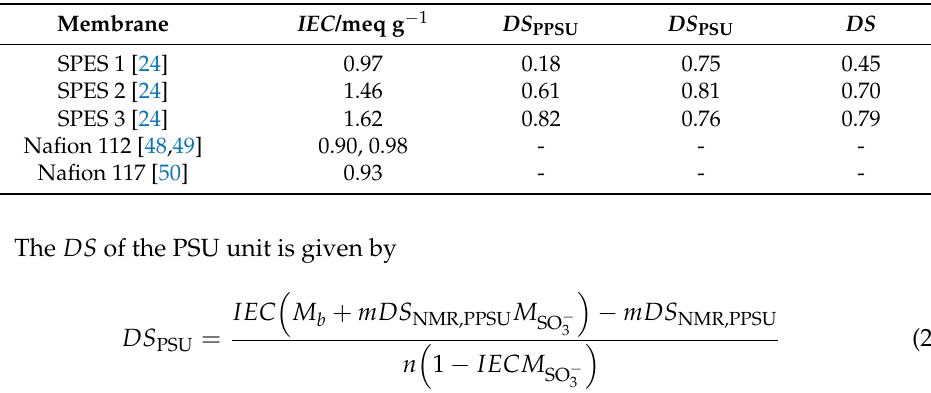
Table 1. Ion-exchange capacity ( IEC ) and average degree of sulfonation ( DS ) of the SPES mem- branes, together with the DS of each block copolymer. The IECs of Nafion 112 and Nafion 117 are also